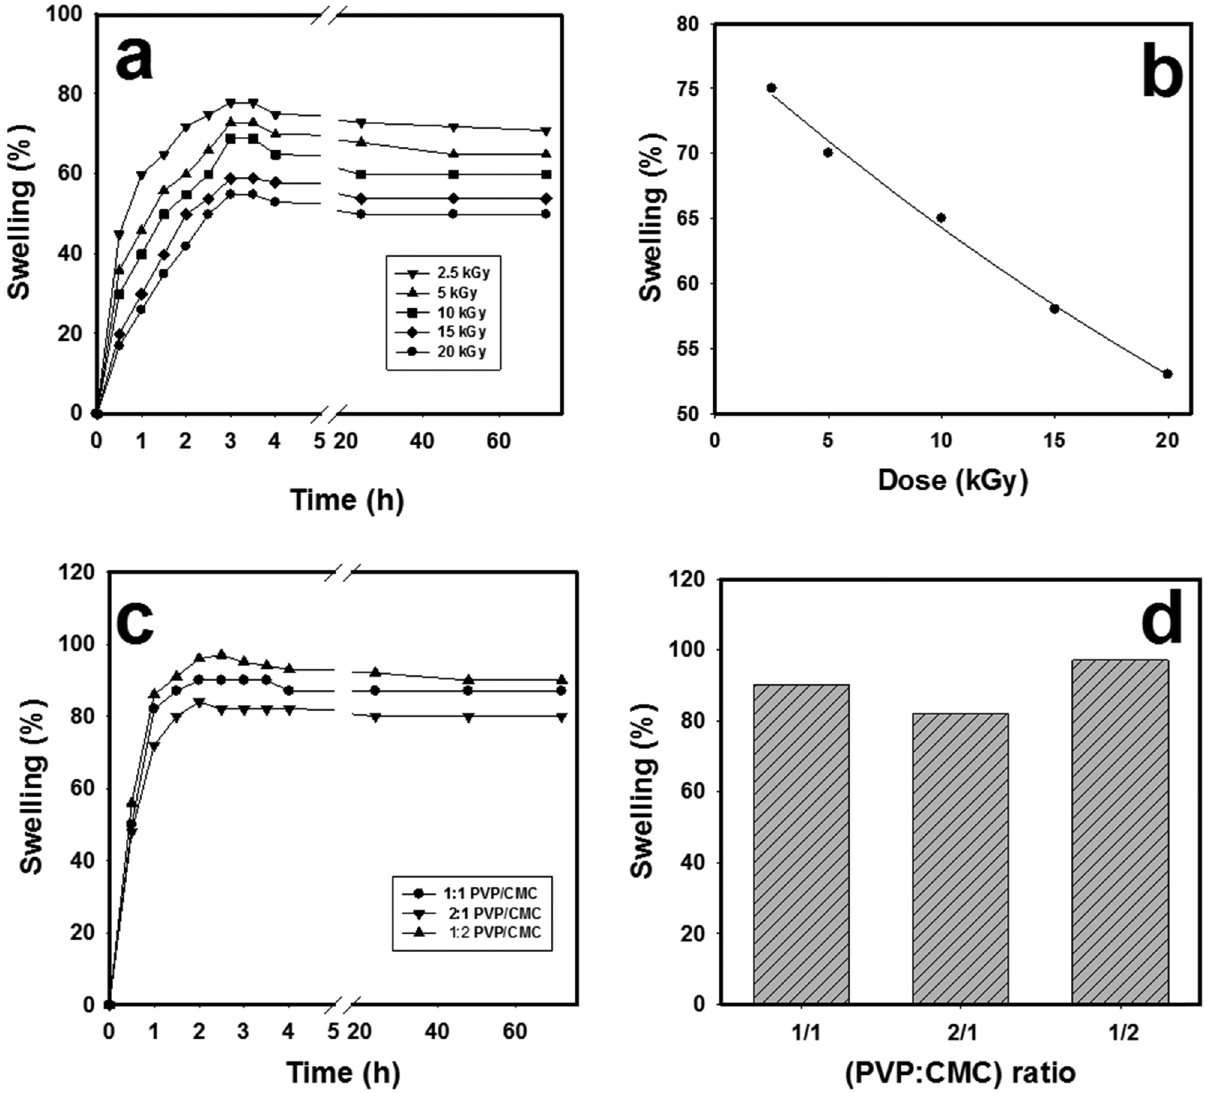
Figure 4: ( a ) E ff ect of irradiation dose on swelling percentage, ( b ) relationship between swelling percentage and irradiation dose, ( c ) e ff ect of PVP:CMC ratio on swelling percentage, and ( d ) relationship between swelling percentage and PVP:CMC